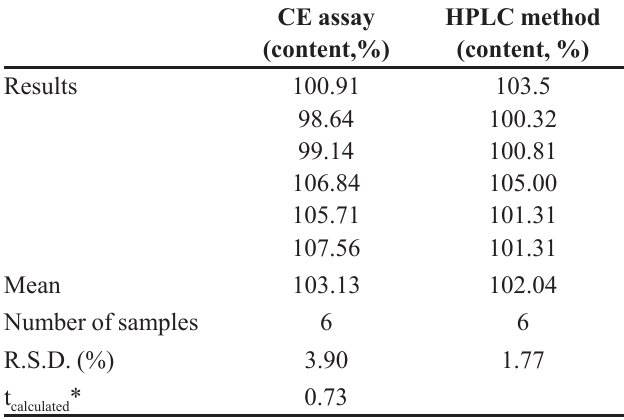
TABLE II - Comparison of CE and HPLC methods for determination of linezolid in Tablets (600